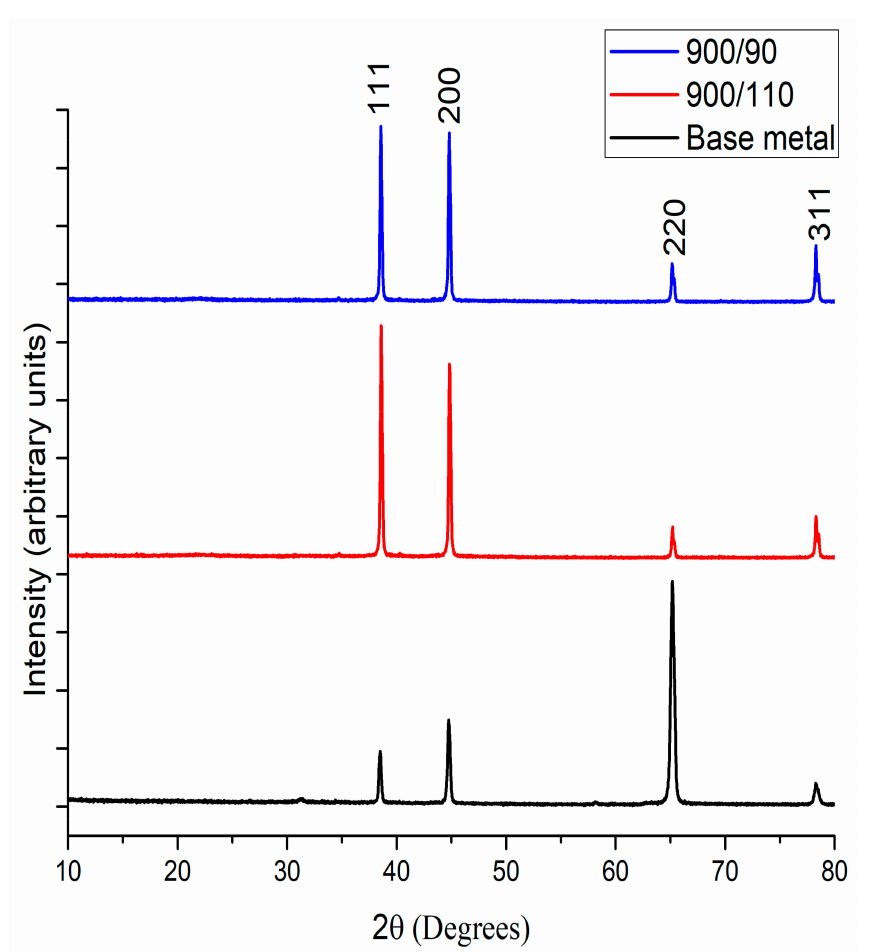
Figure 10. X-ray diffraction pattern of welded sample after corrosion analysis.